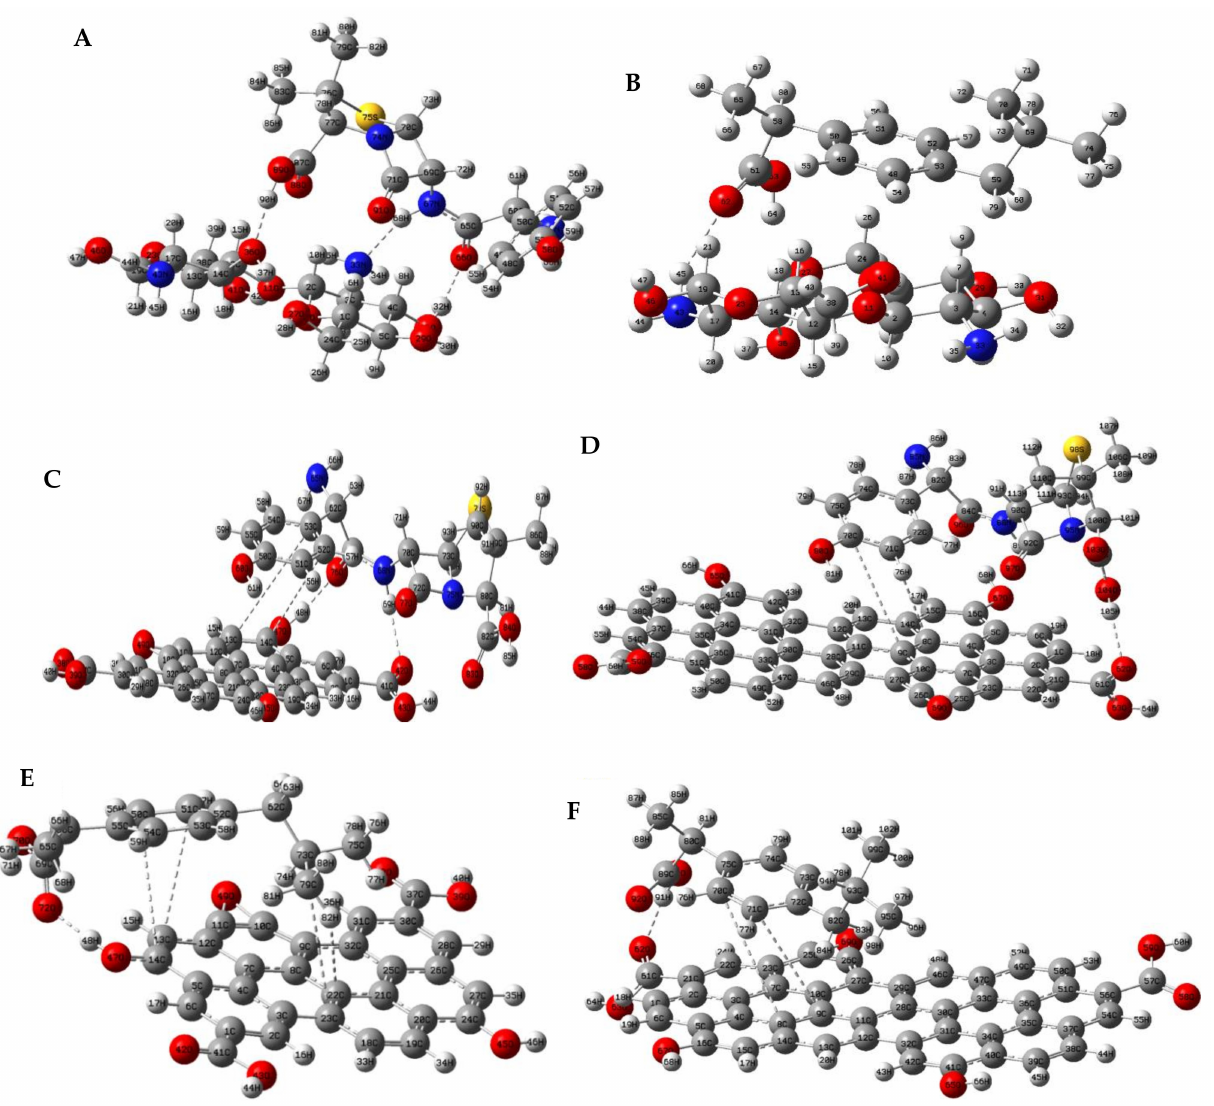
Figure 3. Optimized structures at ω B97X-D/6-311G(2d.p) level of theory for all complexes studied in this work. ( A ) amoxicillin-chitosan; ( B ) ibuprofen-chitosan; ( C ) amoxicillin-GO-1; ( D ) amoxicillin-GO-2; ( E ) ibuprofen-GO-1; ( F ) ibuprofen-GO-2. The dashed line suggests an important molecular